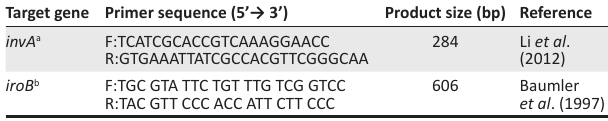
TABLE 1: Primers used to confirm Salmonella